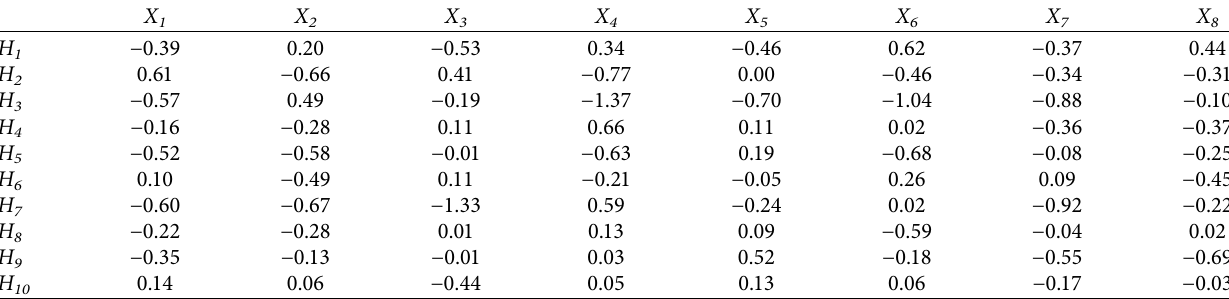
Table 2: Connection weights of the input layer and the hidden layer.